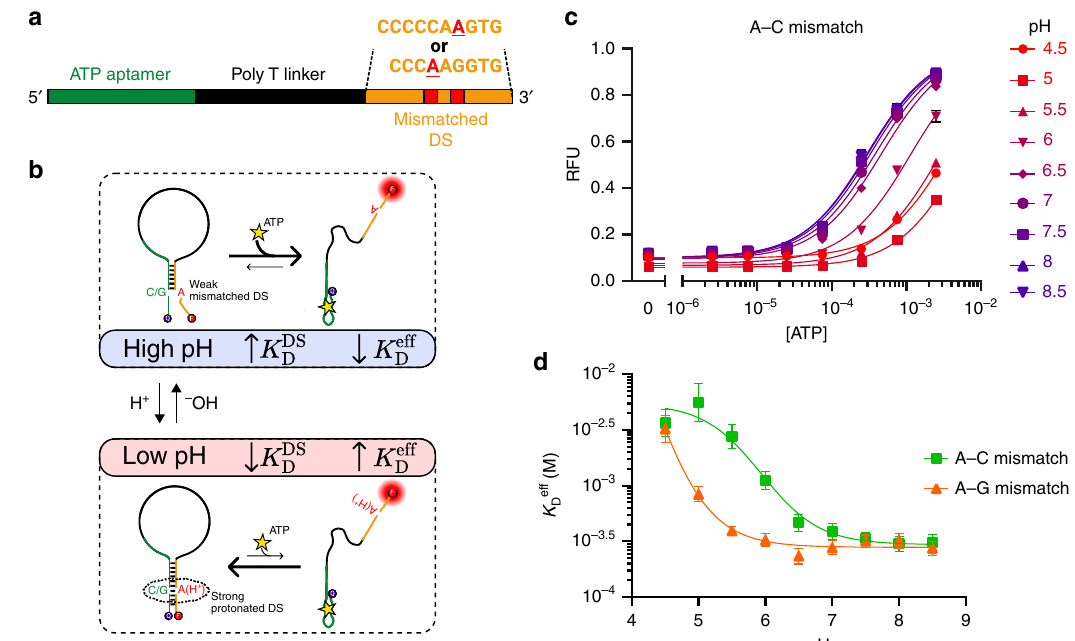
Fig. 3 Rational design of a high pH-speci fi c ATP aptamer. a Preferential binding at neutral or alkaline pH is achieved by introducing an A – C or A – G mismatch into the DS sequence. b A simpli fi ed model for selective binding at higher pH. Mismatch protonation at acidic pH strengthens DS hybridization, decreasing the aptamer ’ s effective af fi nity. A complete three-state model of the binding mechanism is given in Supplementary Fig. 5. c ATP binding curves for the A – C mismatch construct show increasing binding af fi nity at more alkaline pH. d Both A – C and A – G mismatches can be inserted to achieve stronger binding at neutral or alkaline pH than at acidic pH. Data points and error bars in c show the means and standard deviations of n = 3 independent experiments. Data points and error bars in d show the best fi t values and standard deviations extracted from Langmuir isotherm fi ts to binding curve data from n = 3 independent experiments (data given in Supplementary Fig. 6) using nonlinear least squares fi tting. Source data are provided as a Source Data fi